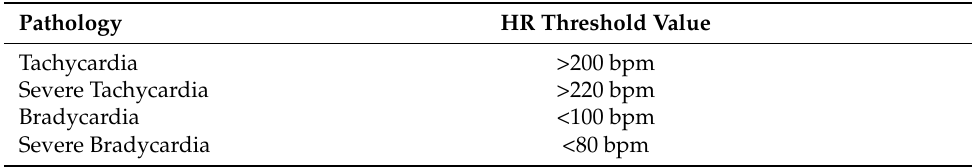
Table 2. Simulated HR-dependent